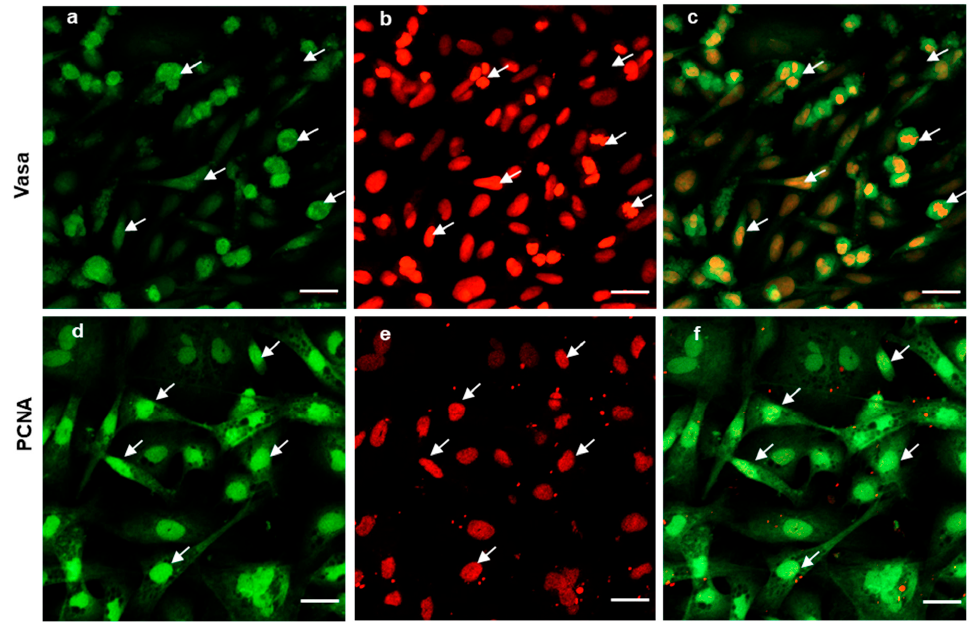
Figure 4. Expression of Vasa and PCNA in the cultured cells. Fluorescent immunostaining analysis of the cultured cells at 6th passage (cultured over 30 days); the cells were stained with polyclonal anti-Vasa antibody (green in a ), and Monoclonal anti-PCNA antibody (green in d ). Nuclei were stained with PI (red in b , e ). Merged images ( c , f ). The arrows indicate the cells expressing both Vasa and PCNA. Scale bars, 20 µm.